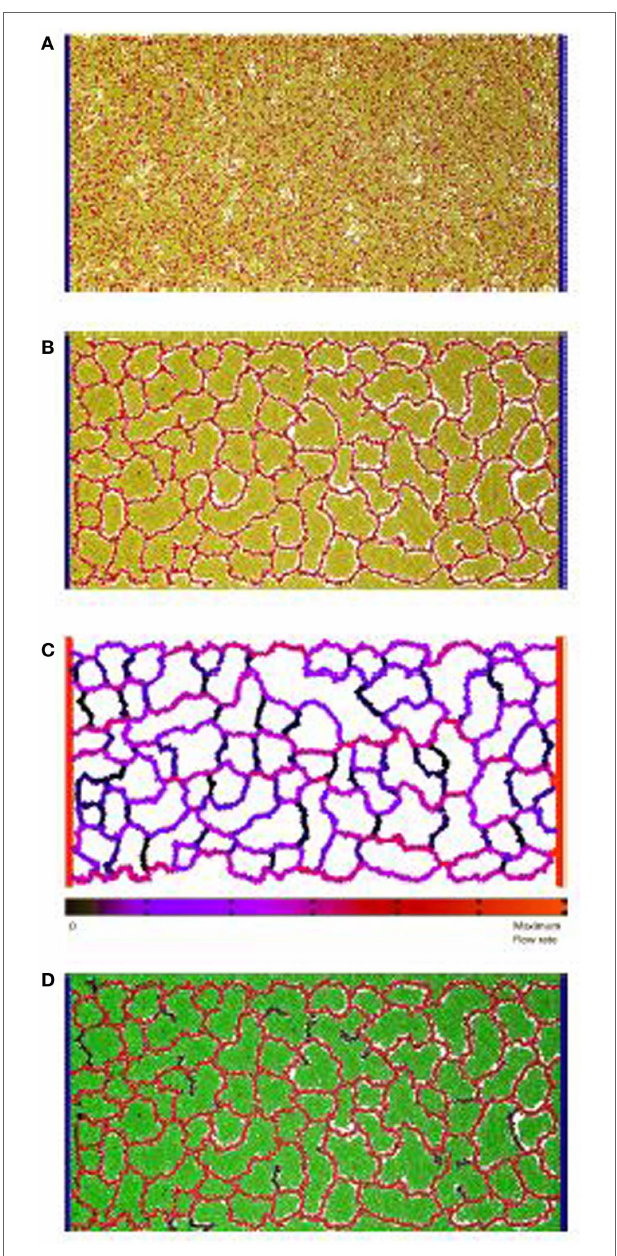
FIGURE 1 | Vascular factory: the three phases in modeling a vascular factory design . Beginning with morphogenesis, where the vessel network self-organizes, followed by network analysis where the flow through the vessels is estimated, and then production, where the producer cells run and the nutrient inflow and the product outflow are calculated. (A) Initial state : random arrangement of vascular cells (red spheres) and inactive producer cells (yellow spheres). The fixed circulatory cells are shown in blue on both sides. (B) Phase I : self-organize the vessel network. Each vascular cell secretes and responds to a chemoatractant. Strong mutual adhesion builds vessels that connect into a near-regular network, partitioning the producer cells in each lacunae. (C) Phase II : determine network flow. A network of pipes is extracted and a pressure differential applied (source and sink). Individual vessel flow is determined by applying Poiseuille’s Law (red is high, black is low). (D) Phase III : run the factory. Nutrient flows into the network and is dispersed, to activate the producer cells (green spheres). The network removes the product, which flows to the